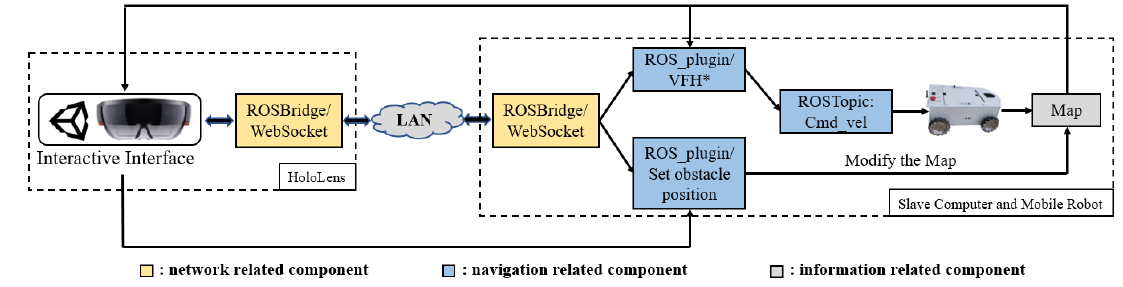
Figure 7. Diagram of software and communication